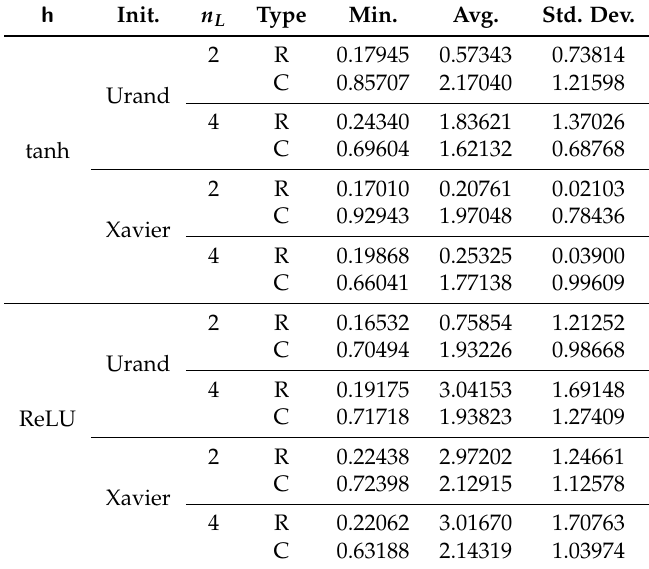
Table 4. E ( Q NN ) results summary for h = tanh and h = ReLU ( M = 8).